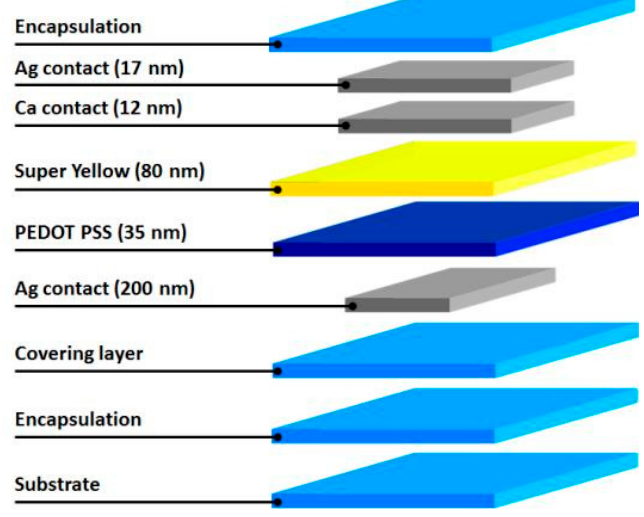
Figure 9. Build-up of the OLED device.